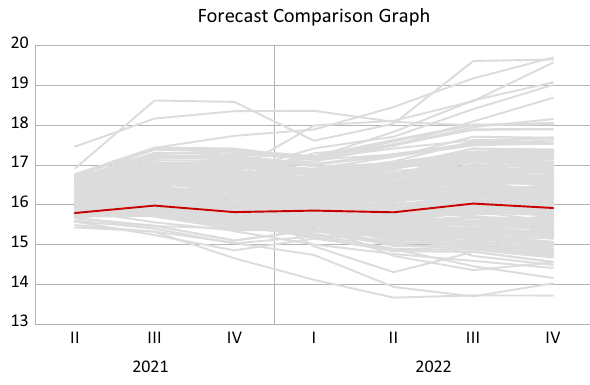
Figure 4: Unemployment forecast under all plausible SARIMA speci fi